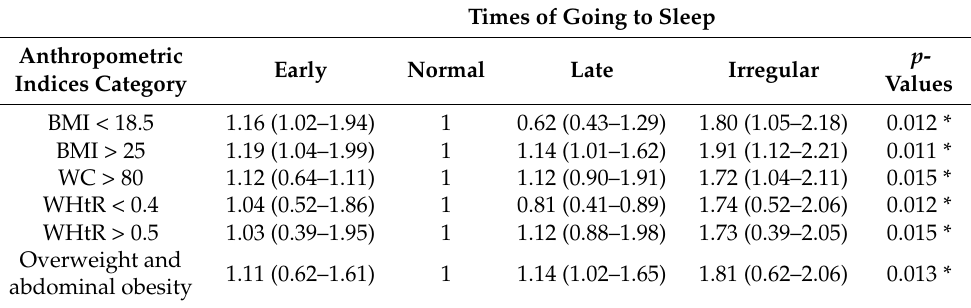
Table 2. The risk (OR and 95% CI) of underweight and overweight and abdominal obesity in relation to times of going to